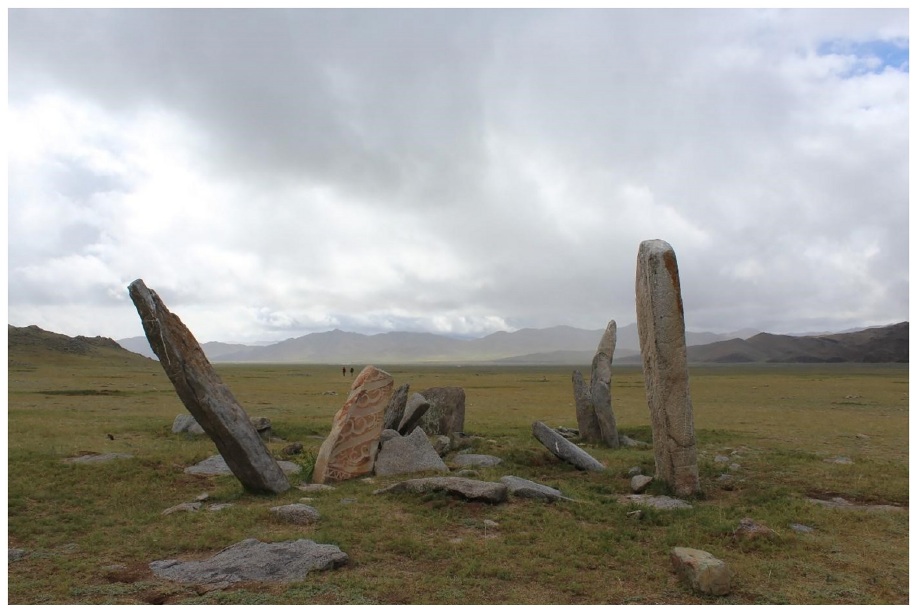
Fig 3. Slab burial built of uprooted deer stones at the site of Shatar Chuluu in Bayankhongor, central Mongolia.